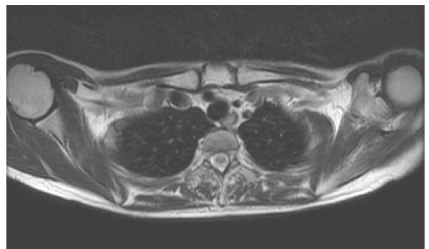
Figure 6: T2-weighted magnetic resonance images taken at the final follow-up 12 years postoperatively. There was no abnormality of the soft tissue or bony structures, although some asymmetry existed.